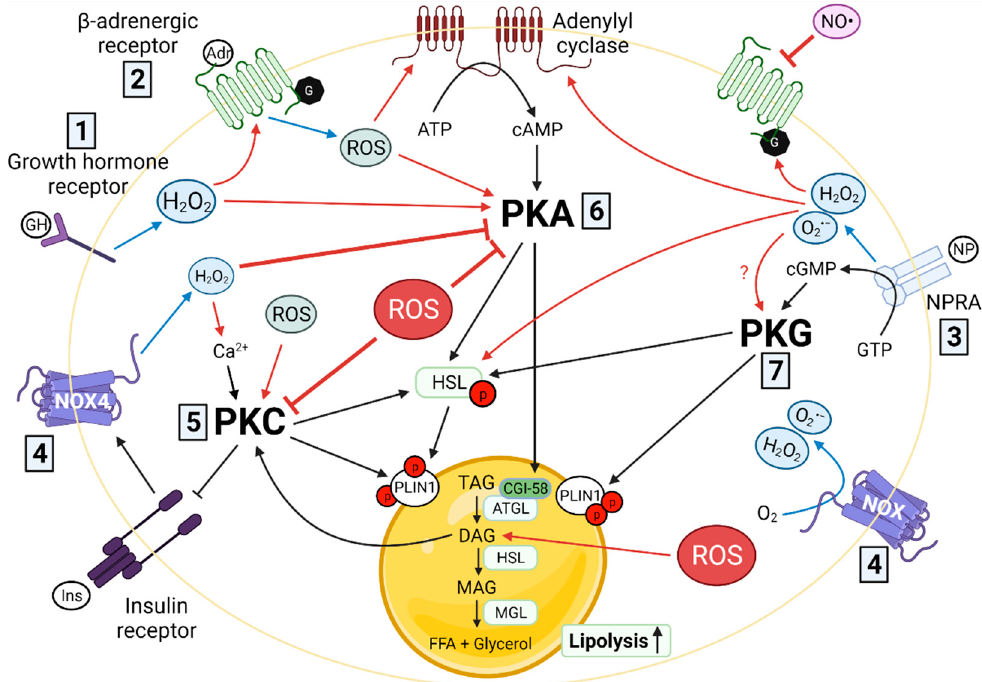
Figure 2. Redox signaling and lipolysis. ROS and RNS alter lipolytic pathways at different points. (1) Growth hormone receptor : ROS, especially H 2 O 2 , production increases upon growth hormone (GH) binding to the growth hormone receptor, consequently activating β -adrenergic receptor ( β AR), adenylyl cyclase (AC), and protein kinases downstream, increasing lipolysis. (2) β -adrenergic receptor : Adrenalin (Adr) binds to β AR and increases the production of ROS. O 2 •− and H 2 O 2 also oxidize β AR, increasing adipocyte sensitivity to lipolysis. On the other hand, NO • suppresses β AR activation. (3) Natriuretic peptide receptor : O 2 •− and H 2 O 2 produced upon activation of NPRA enhance the activation of β AR, AC, and cAMP synthesis, increasing lipolysis. (4) Nicotinamide adenine dinucleotide phosphate oxidase : NOX converts O 2 to O 2 •− and H 2 O 2 . Moreover, insulin, through the production H 2 O 2 by NOX4, inhibits PKA activation, reducing adrenergic stimulated lipolysis. (5) Protein kinase C ( PKC) : at high concentration, O 2 •− and H 2 O 2 activate PKC through the release of diacylglycerol (DAG) or may inactivate it by impairing its substrate-binding affinity. At low concentrations, ROS activate PKC by oxidizing its structural cysteine residues. H 2 O 2 activates PKC by increasing Ca 2+ concentrations. (6) Protein kinase A (PKA) : at high concentration, ROS inhibit cAMP-dependent PKA, but at low concentration, ROS prolong the activation of PKA by inhibiting the phosphatase that suppresses it. (7) Protein kinase G (PKG) : it is currently unknown how ROS affect PKG activity in adipocytes. Black arrows represent the classic lipolytic pathway, blue arrows represent the production of ROS/RNS, and red arrows represent the effect (activation or inhibition) of